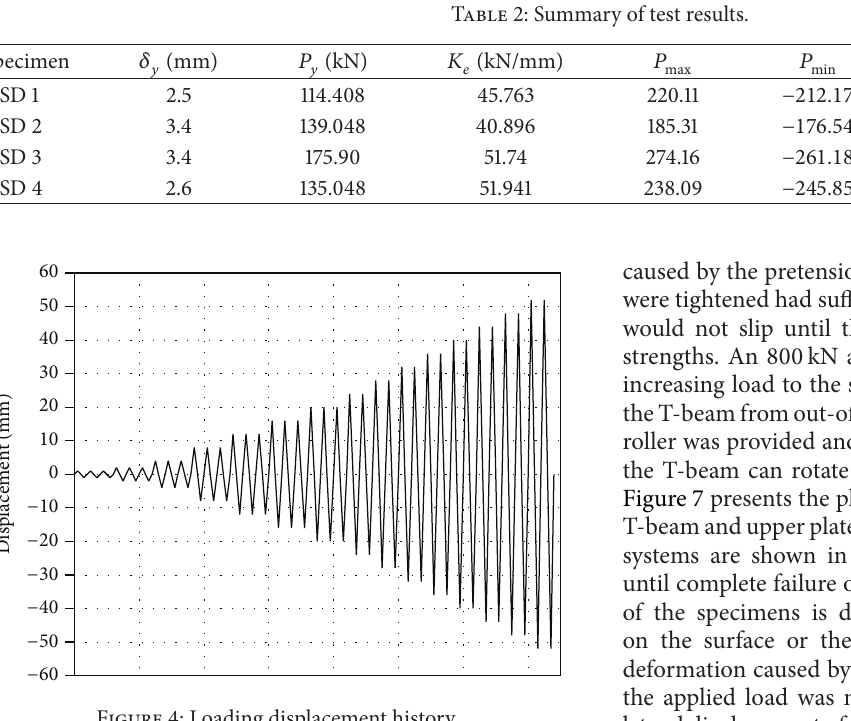
Figure 4: Loading displacement history.